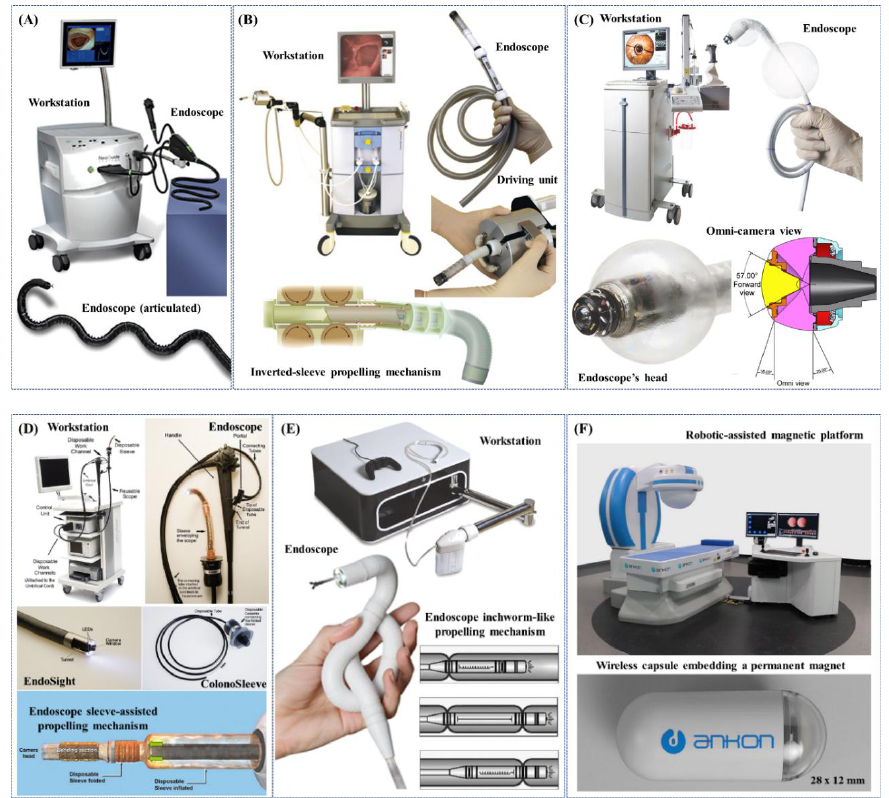
Figure 3. Examples of certified robotic flexible colonoscopes (commercially-available or certified but no longer on the market): ( A ) NeoGuide Endoscopy System (NeoGuide Endoscopy System Inc., Los Gatos, CA USA) [88]; ( B ) Invendoscope ™ SC40 (Invendo Medical GmbH, Weinheim, Germany) [88]; ( C ) Aer-O-Scope System (GI View Ltd., Ramat Gan, Israel) [81]; ( D ) ColonoSight (Stryker GI Ltd., Haifa, Israel) [82]; ( E ) Endotics System (ERA Endoscopy Srl, Pisa, Italy) (Courtesy of ERA Endoscopy Srl) [88]; ( F ) NaviCam ® (Ankon Technologies Co, Ltd. Wuhan, Shanghai, China)